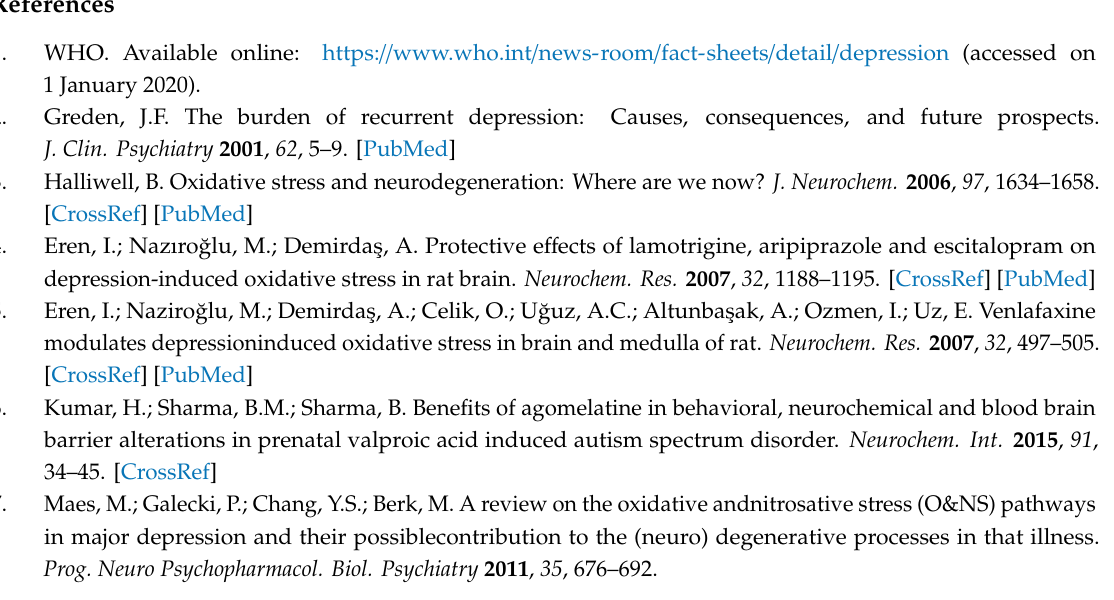
Table S1: Characteristics of the genes studied (All data contained in the table were compiled with the help of Genomatix Software Suite, Intrexon Bioinformatics Germany GmbH, Munich, Germany, 2019), Table S2: Conditions of the antibodies used in the Western blot analysis, Table S3: The characteristics of primers used for analysis of methylation levels in the promoter regions of the studied genes, Table S4: The e ff ects of chronic mild stress and treatment on sucrose intake in controls, depressed rats and rats after treatment with venlafaxine (N = 6), Table S5: The methylation status of CAT promoter (A) Gpx1 promoter (B), Gpx4 promoter 2 (C) Gpx4 promoter 3 (D) SOD1 (E), SOD2 (F) NOS1 promoter 3 (G), NOS1 promoter 7 (H) in hippocampus, amygdala, hypothalamus, midbrain, cortex and basal ganglia of animals exposed to CMS procedure for two weeks (Control, Stressed) and in animals exposed to CMS procedure for seven weeks and administered vehicle (1 ml / kg) or agomelatine (10 mg / kg) for five weeks (Control / Ago, Stressed / Saline, Stressed / Ago), Figure S1: Di ff erences in CAT (A) SOD1 (B), SOD2 (C), Gpx1 (D), Gpx4 (E) gene expression between hippocampus, amygdala, hypothalamus, midbrain, cortex and basal ganglia and PBMCs of animals exposed to CMS procedure for two weeks (Control, Stressed) and in animals exposed to CMS procedure for seven weeks and administered vehicle (1 ml / kg) or agomelatine (10 mg / kg) for five weeks (Control / Ago, Stressed / Saline, Stressed / Ago), Figure S2: CAT (A), SOD1 (B), SOD2 (C), Gpx1 (D), Gpx4 (E) mRNA expression in PBMCs and in the hippocampus, amygdala, hypothalamus, midbrain, cortex and basal ganglia of animals exposed to CMS procedure for two weeks (Control, Stressed) and in animals exposed to CMS procedure for seven weeks and administered vehicle (1 ml / kg) or agomelatine (10 mg / kg) for five weeks (Control / Ago, Stressed / Saline, Stressed / Ago), Figure S3: The methylation status of Cat promoter (A) Sod1 (B), Gpx1 (C), NOS1 promoter 7 (D) in PBMCS of animals exposed to CMS procedure for two weeks (Control, Stressed) and in animals exposed to CMS procedure for seven weeks and administered vehicle (1 ml / kg) or agomelatine (10 mg / kg) for five weeks (Control / Ago, Stressed / Saline, Stressed / Ago), Figure S4: Di ff erences in the methylation status of CAT (A), Gpx1 (B) Gpx4 promoter 2 (C) promoter 3 (D), SOD1 (E), SOD2 (F) and NOS1 promoter 3 (G), promoter 7 (H) between hippocampus, amygdala, hypothalamus, midbrain, cortex and basal ganglia and PBMCs of animals exposed to CMS procedure for two weeks (Control, Stressed) and in animals exposed to CMS procedure for seven weeks and administered vehicle (1 ml / kg) or agomelatine (10 mg / kg) for five weeks (Control / Ago, Stressed / Saline, Stressed / Ago), Figure S5: SOD1 (A) and NOS1 (B) protein expression in animals exposed to CMS procedure for two weeks (Control, Stressed) and in animals exposed to CMS for seven weeks and administered vehicle (1 ml / kg) or agomelatine (10 mg / kg) for five weeks (Control / Ago, Stressed / Saline, Stressed /